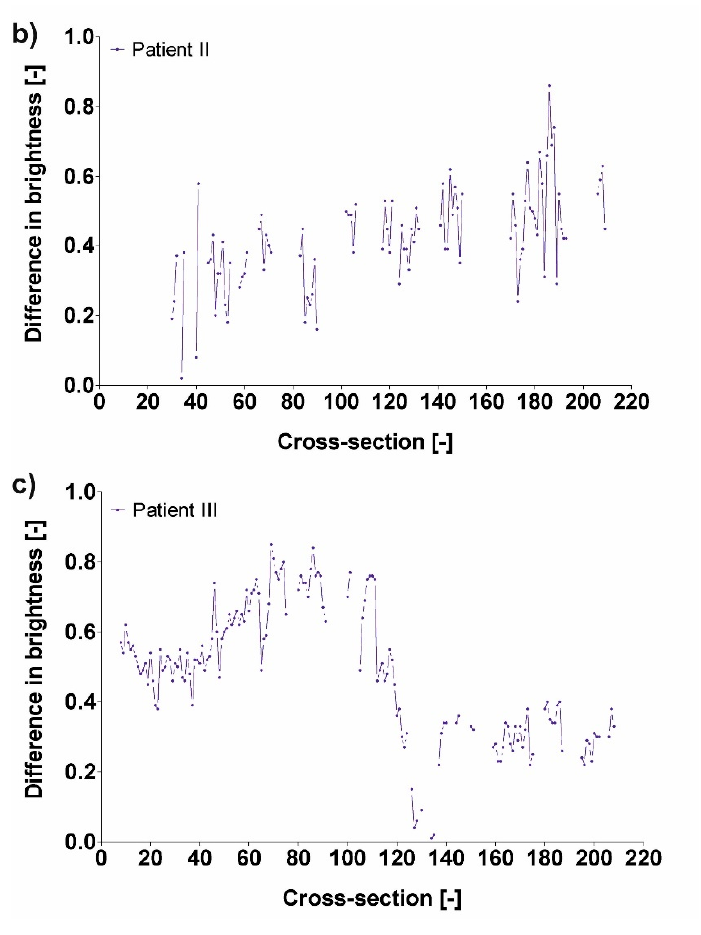
Figure 10. Difference in brightness value for ( a ) Patient I, ( b ) Patient II, and ( c ) Patient III.